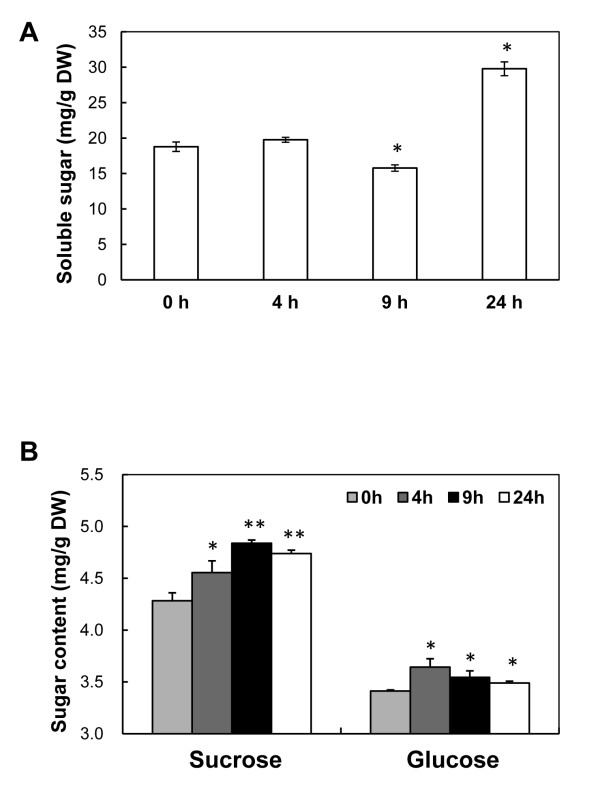
Contents of total soluble sugars (A) and sucrose and glucose (B) in cassava leaves subjected to cold (7°C) for 0, 4, 9, and 24 h. The single and double asterisks indicate a statistically significant difference at p < 0.05 and p < 0.01, respectively, for the data of the stress-treated samples compared to those of the unstressed samples. The mean values are calculated from three biological replicates; the error bars represent the standard error of the mean (SEM).